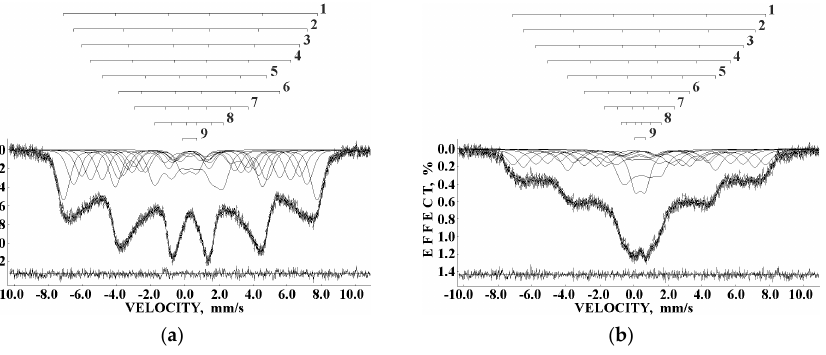
Figure 44. Mössbauer spectra of the FM ( a ) and FMC ( b ) nanoparticles measured at 295 K in 4096 channels and converted into 1024 ‐ channel spectra. Indicated components 1–9 are the results of the best fits. The differential spectra are shown on the bottom.